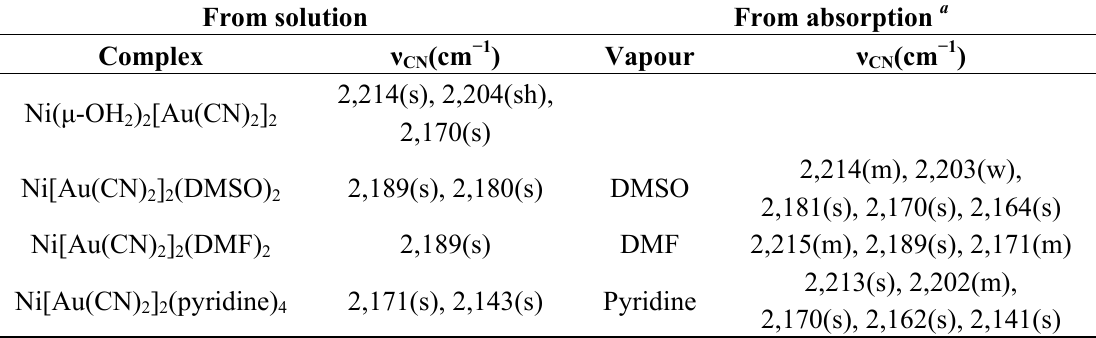
Figure 1. Powders of Co[Au(CN) Co[Au(CN) Co[Au(CN) absorption by solid Co[Au(CN)